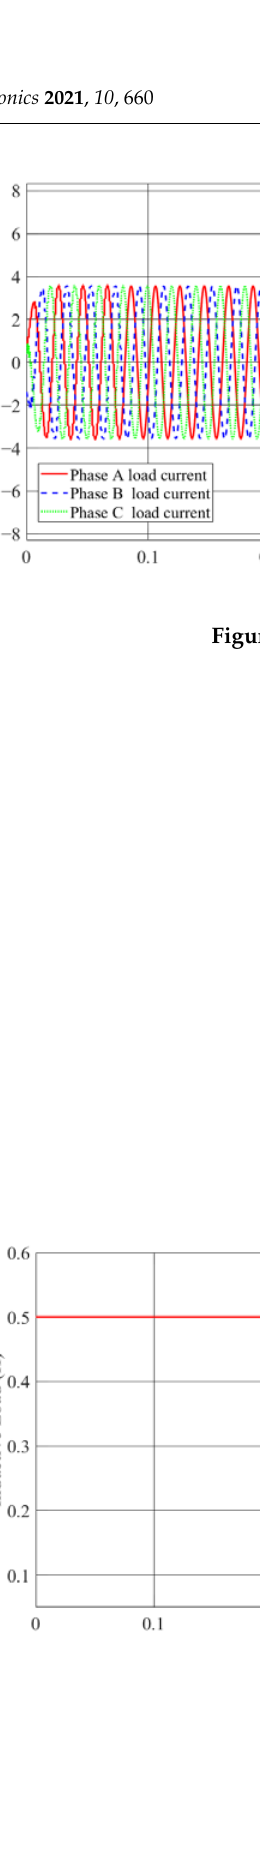
Figure 8. Output voltage of microgrid by NLIB controller in d - q frame zoomed-in view.